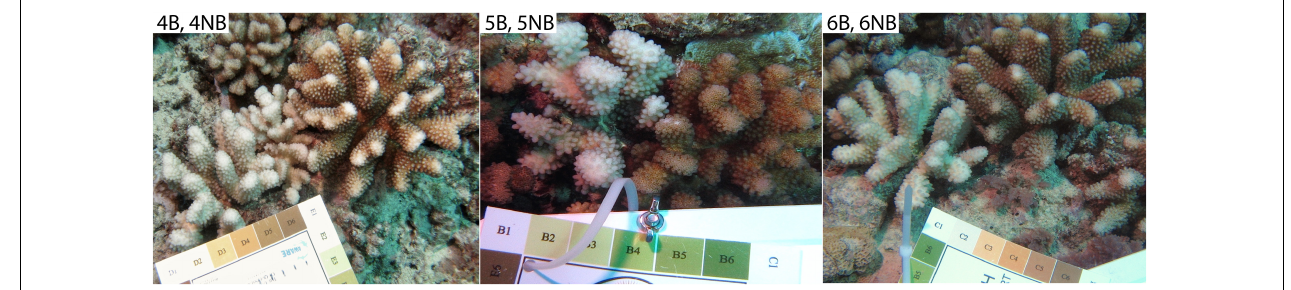
FIGURE 1 | The three coral colony pairs used for viral metagenomic analysis. Corals were found on the northern forereef off the island of Mo’orea, French Polynesia. Coral Health Chart colors indicate extent of bleaching for each coral colony (#1 bleached to #6 healthy). All corals were identified as Pocillopora spp.